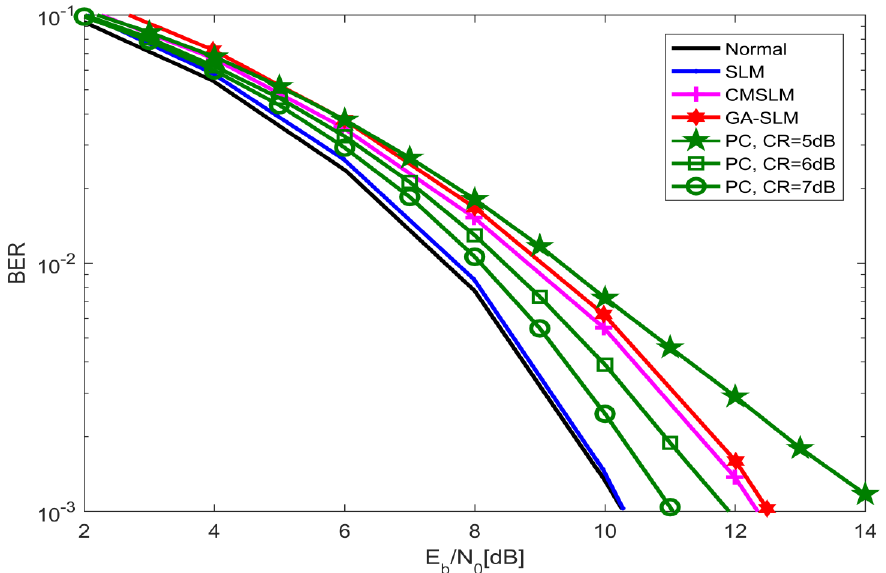
Figure 21. BER performance of the proposed method compared with SLM and its variants with N = 64, and the modulation 16-QAM over the AWGN channel.